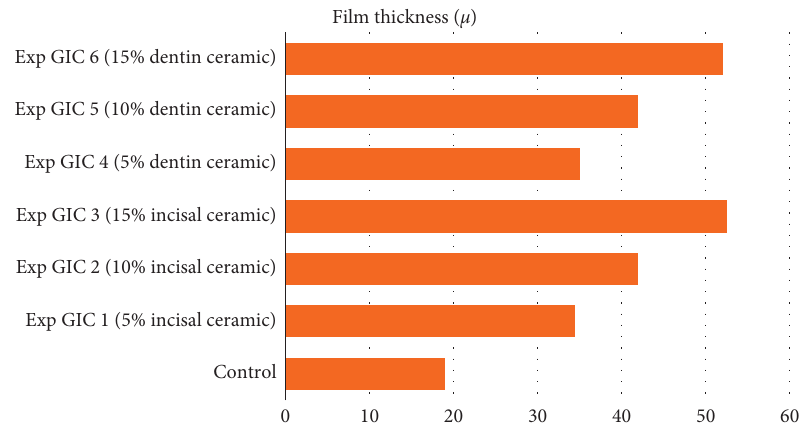
Figure 3: Film thickness of samples in Group 1.